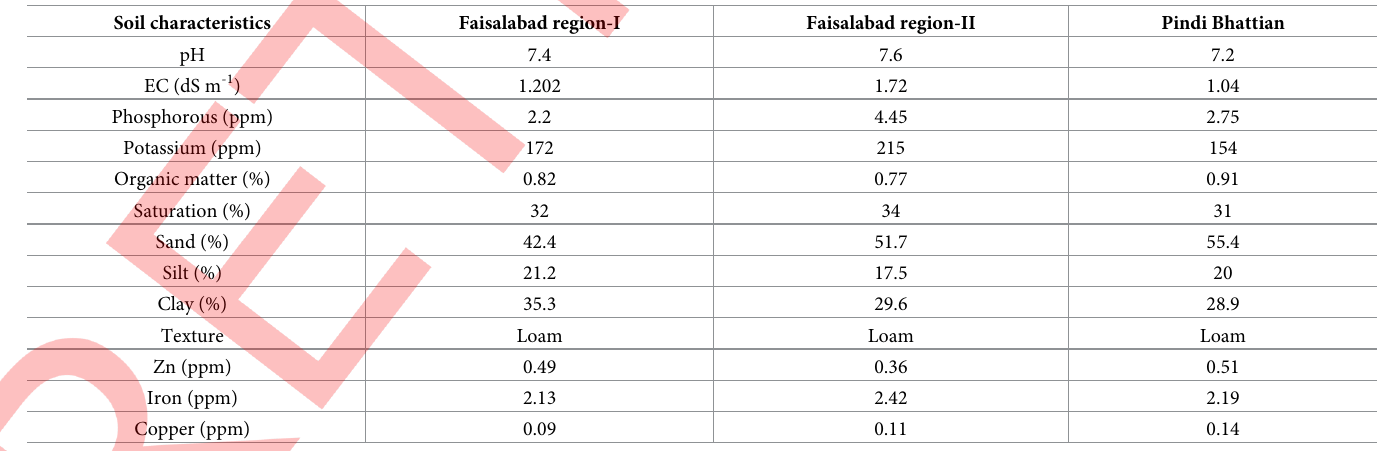
Table 2. Different physical and chemical characteristics of soil collected from three different regions. Soil